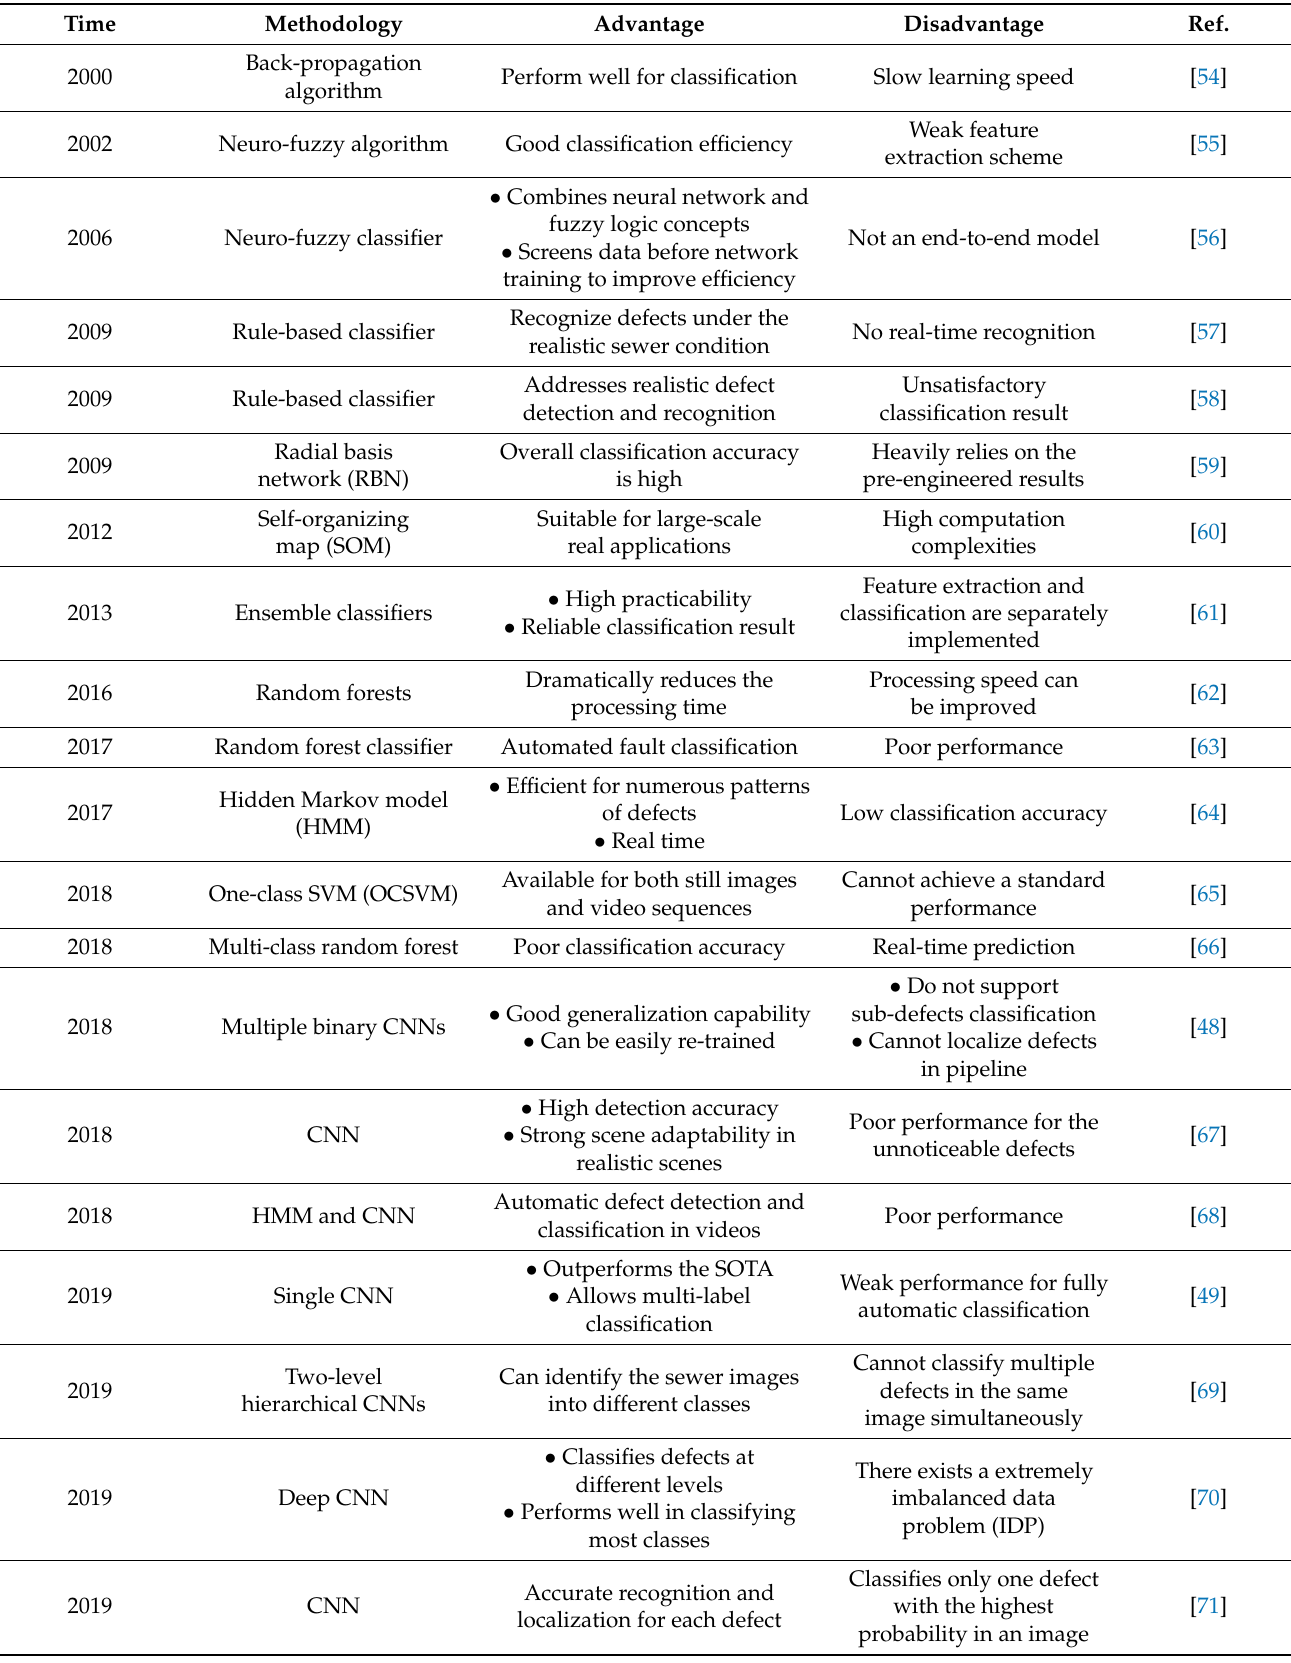
Table 2. Academic studies in vision-based defect classification